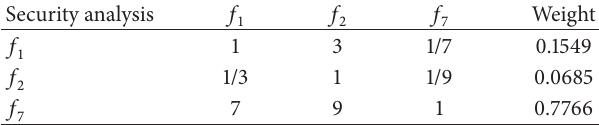
Figure 3: IEEE distribution system diagram with 16 feeders. Table 1: Judgment matrix and weight for the security analysis.